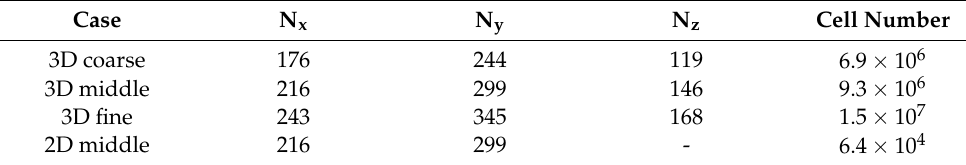
Table 2. Grid settings of the computational